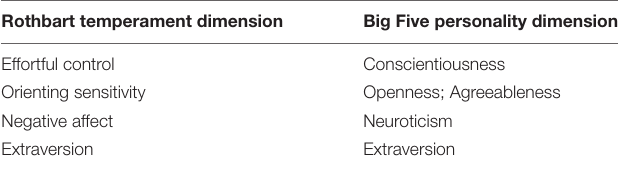
TABLE 1 | Rothbart’s temperament model and the Big Five model of